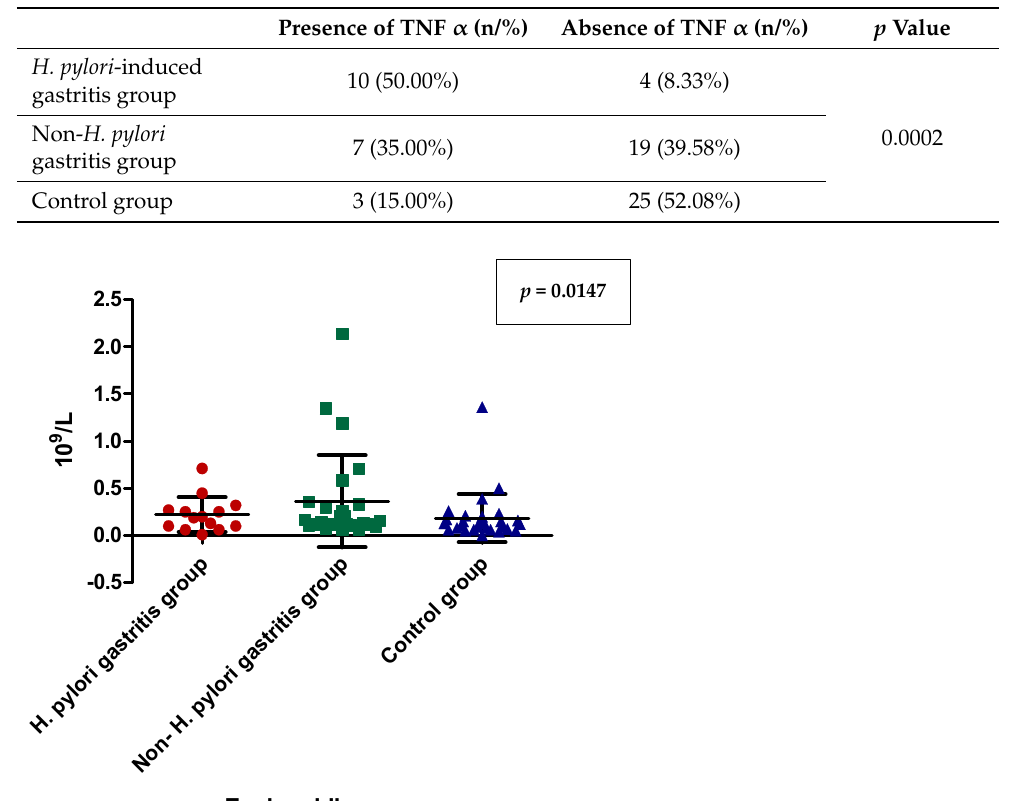
Table 8. Correlation between the presence of TNF α in the three groups.